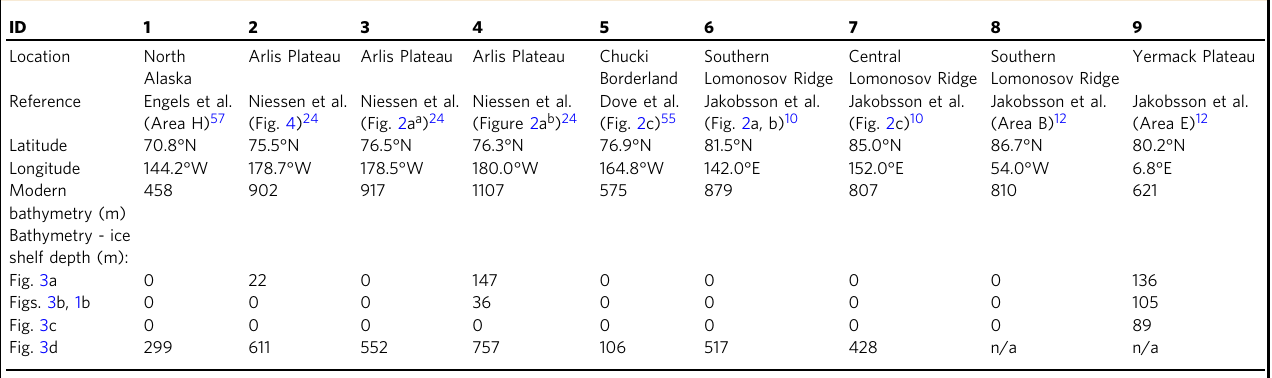
Table 1 Water depth and simulated ice shelf thickness at ice grounding